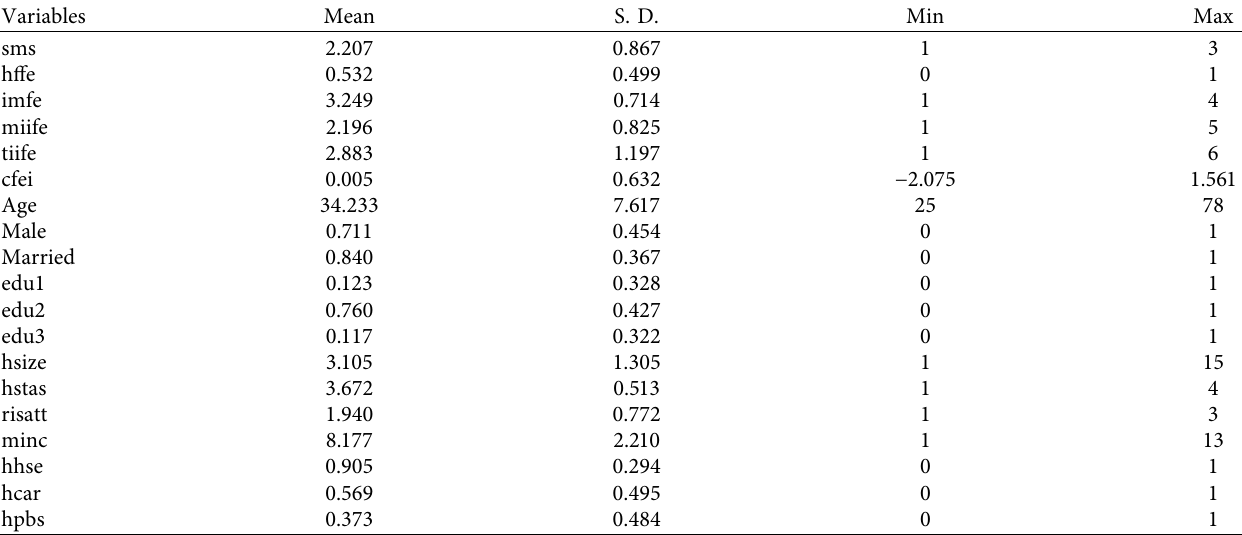
Table 2: Descriptive statistics.